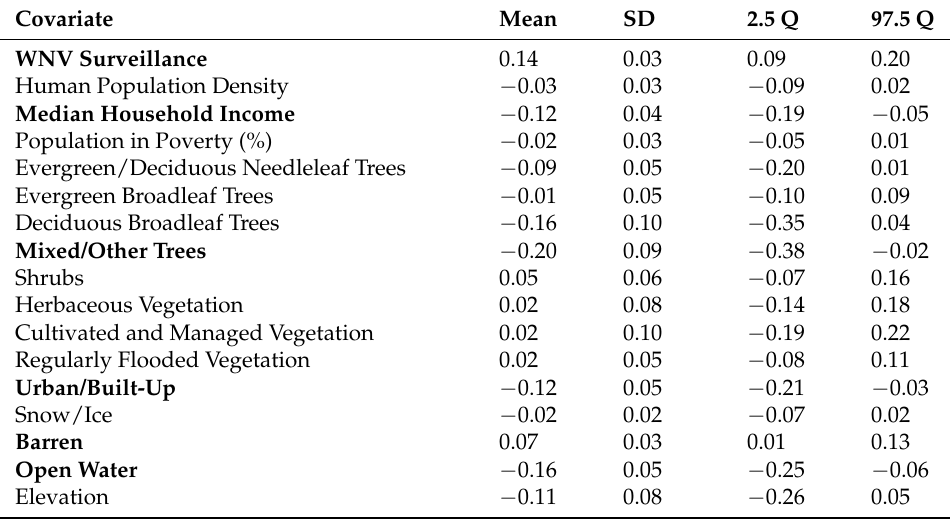
Figure 2. WNV detection probability. WNV surveillance covariate estimated from virus detections reported to the CDC. Mapped counties are color coded according to legend at bottom to indicate WNV detection probability (converted to percent chance). Darker tones indicate an elevated chance of virus detection whereas lighter tones represent a lesser chance of detection. Covariate construction is detailed in Section 2.2. Table 1. Estimated coefficients for equine WND. Mean, standard deviation (SD) and 95% Credible Intervals. Coefficients are on the log scale with covariates judged to be significant based on credible intervals shown in bold